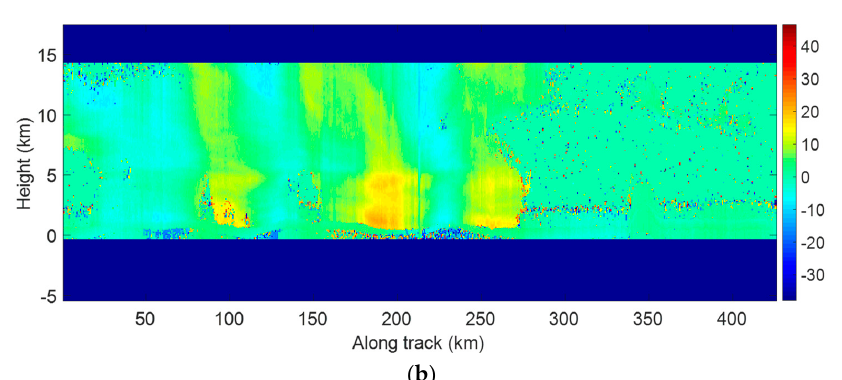
Figure 9. Vertical cross section of HIWRAP observations of Hurricane Ingrid between 18:34 and 19:14 UTC 15 September 2013. ( a ) Reflectivity (dBZ); ( b ) Doppler velocity (m/s).